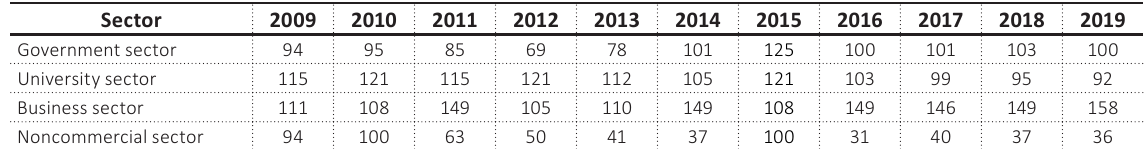
Table 2. Internal R&D expenditures by sector of performance for 2009–2019, in million KZT